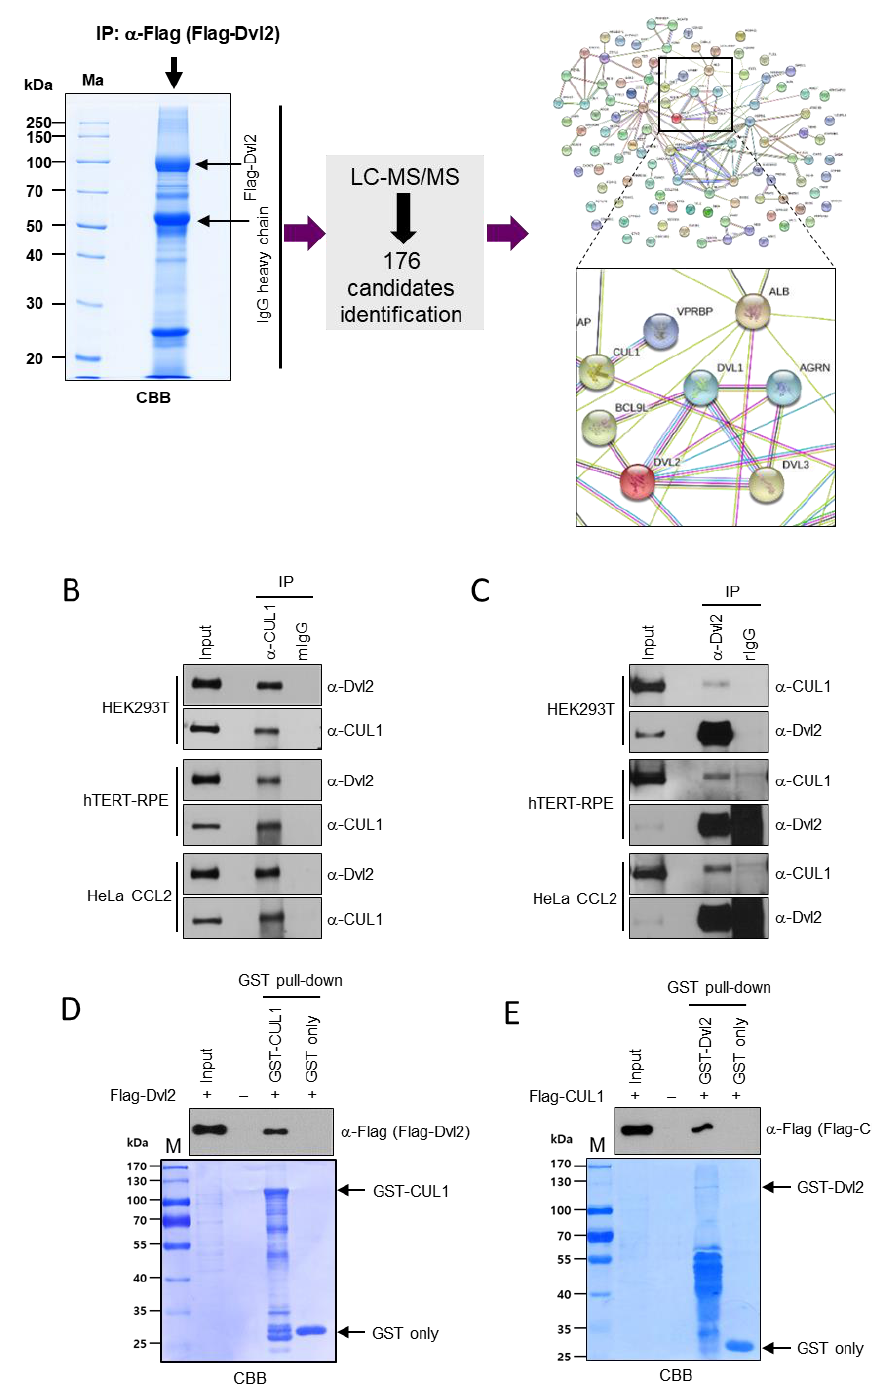
Figure 1. Dvl2 interacts with CUL1 E3 ligase. ( A ) HeLa cells transfected with pFlag-tagged Dvl2 WT were harvested and subjected to an IP assay with an anti-Flag antibody. The precipitates were separated using 10% SDS-PAGE, and stained bands were excised from the gel (left) and subsequently analyzed by MS to identify the interacting proteins (middle). The STRING protein-protein interaction network represents the interactions between 176 proteins isolated from LC-MS/MS (right). Different colors represent different kinds of evidence of the connection between proteins (right). In the STRING network, each line color represents the following meaning: green, neighborhood; red, gene fusion; blue, co-occurrence; black, coexpression; pink, experimental evidence; turquoise, database evidence; light green, evidence from text mining; violet, homology between the two proteins. Note that there is no direct connection between CUL1 and Dvl2 in the STRING network. ( B , C ) Physical interaction between endogenous CUL1 and Dvl2 in asynchronously growing HEK293T, hTERT- RPE, or HeLa CCL2 cell lines. Total cell lysates from various cells were subjected to IP with anti-CUL1 ( B ) or anti-Dvl2 ( C )